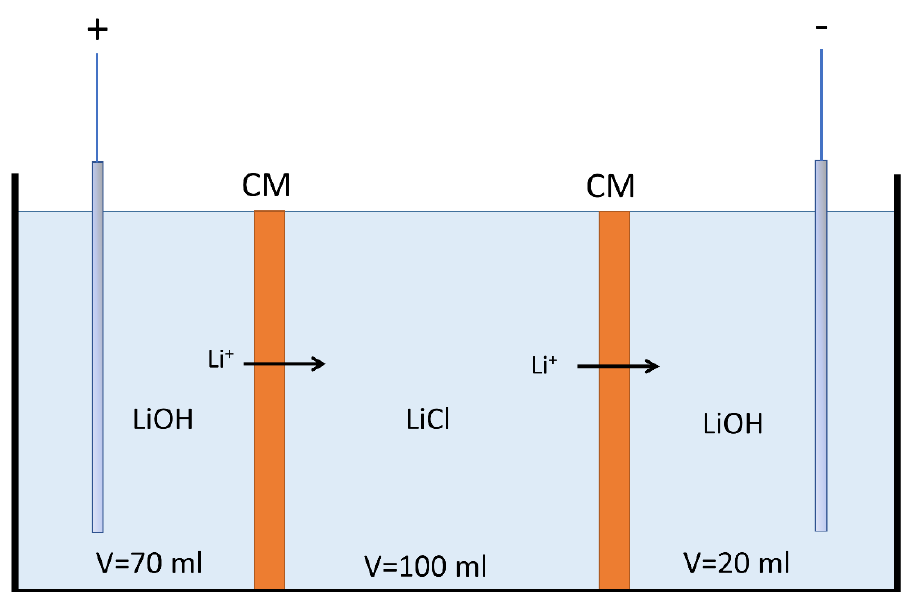
Figure 1. Hittorf method experimental scheme for the determination of lithium ion transport number (CM: Cation exchange membrane). Table 3. Initial LiCl and LiOH concentrations in solution for lithium ion transport number determination.